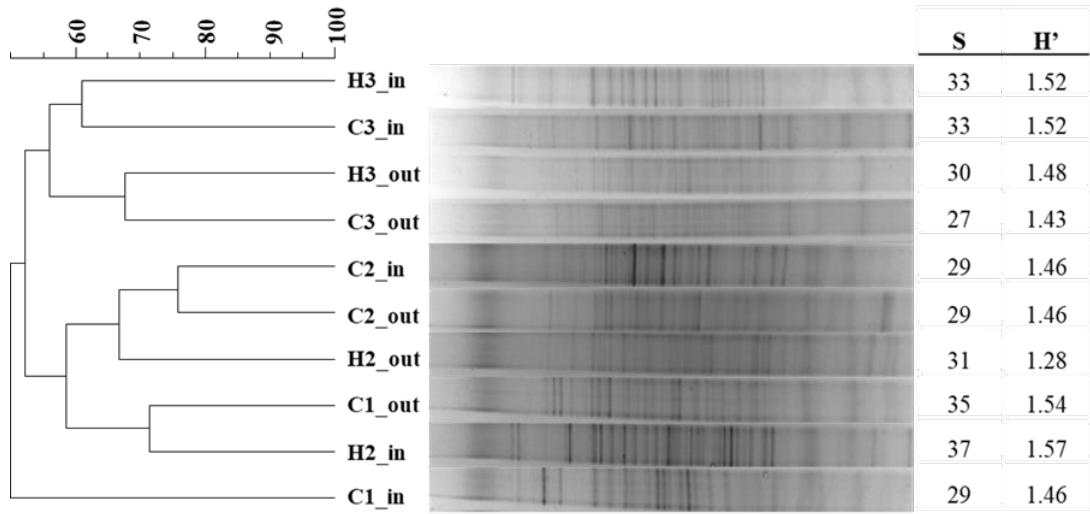
Figure 3. Cluster analysis generated by the 16S rRNA DGGE patterns of bacterial communities associated to the substrate in the inlet (in) and outlet (out) zone of the CW, in cold (C) and hot (H) seasons across three consecutive years (1, 2, 3). The dendrogram was created using the UPGMA clustering method based on Jaccard coefficient. The species richness (S) and the Shannon–Wiener index (H’) is presented.